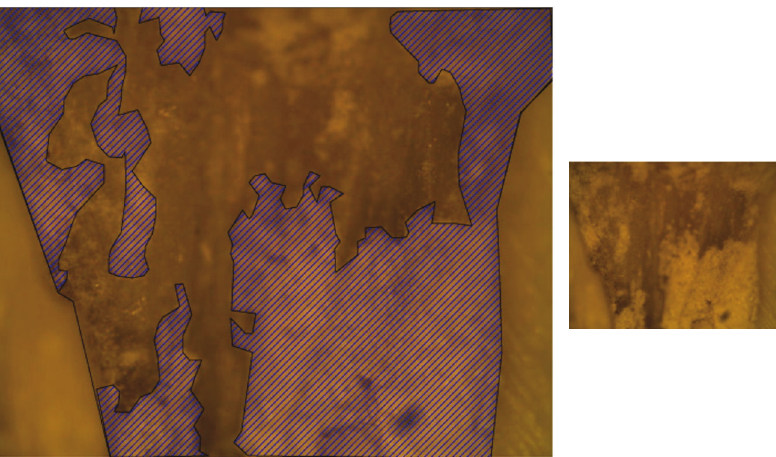
Figure 1: Root filling material remaining in the apical third of a specimen obturated with gutta-percha/AH plus sealer, and retreated using Hedstr¨om files.